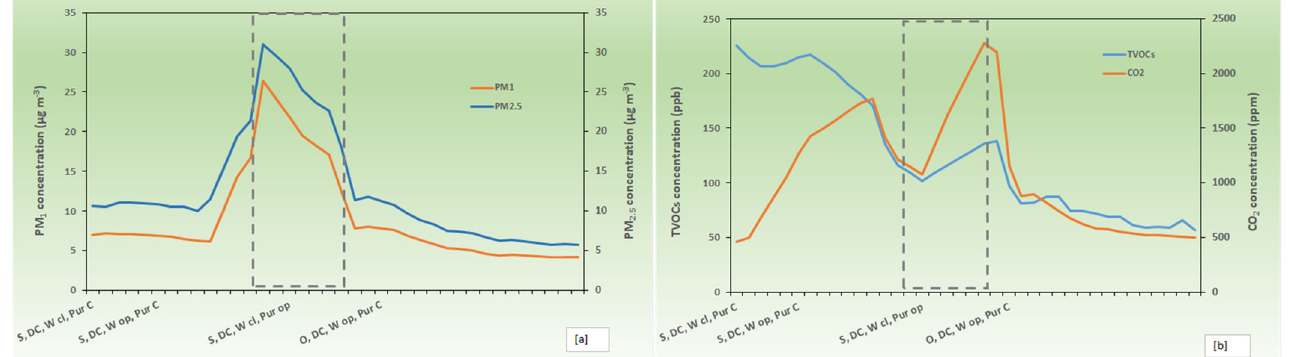
Figure 5. Campaign 3, Class: The effect on PM mass concentrations ( a ) and on gaseous air pollutants ( b ) of air purifier, people’s presence, and windows or doors being opened during lectures (S = students present, W cl or W op = windows closed or open, DC or D op = door closed or open, O = empty room, and Pur C or Pur op = air purifier closed or open). The dotted rectangle depicts the operation of the air purifier. Table 3. Descriptive statistics of indoor and outdoor atmospheric pollutant concentrations along with air temperature and RH (Campaign 2 and